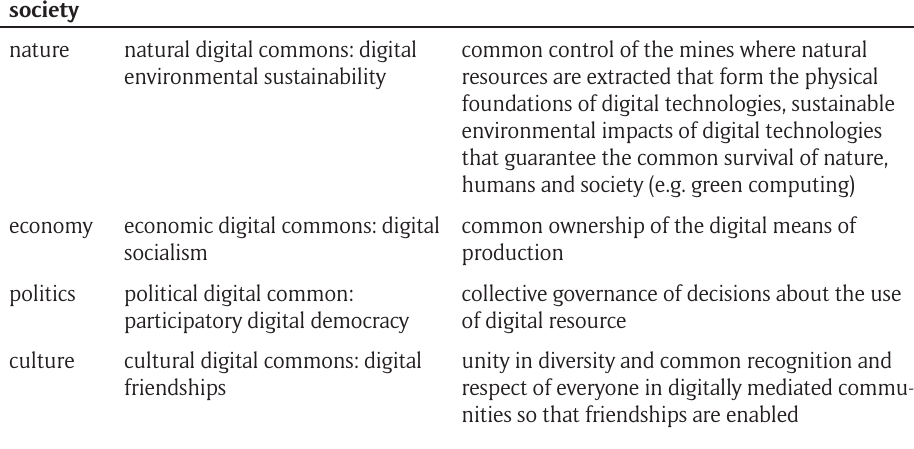
Table 3: Four types and dimension of the digital